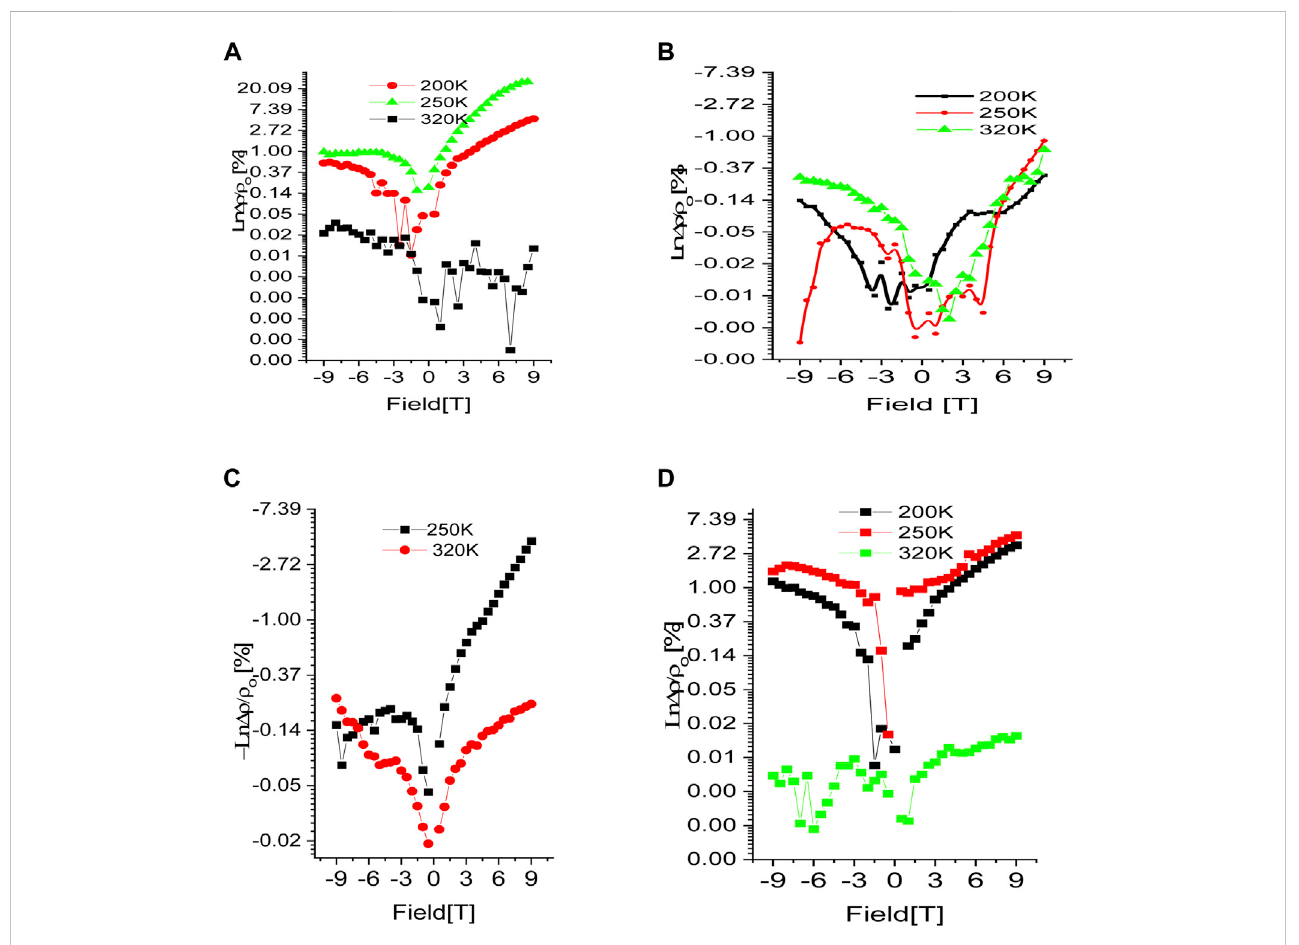
FIGURE 8 Magnetic fi eld dependence of MR in samples (A – D) . Noticeably, samples (A, D) show positive MR while samples (B, C) show negative MR.